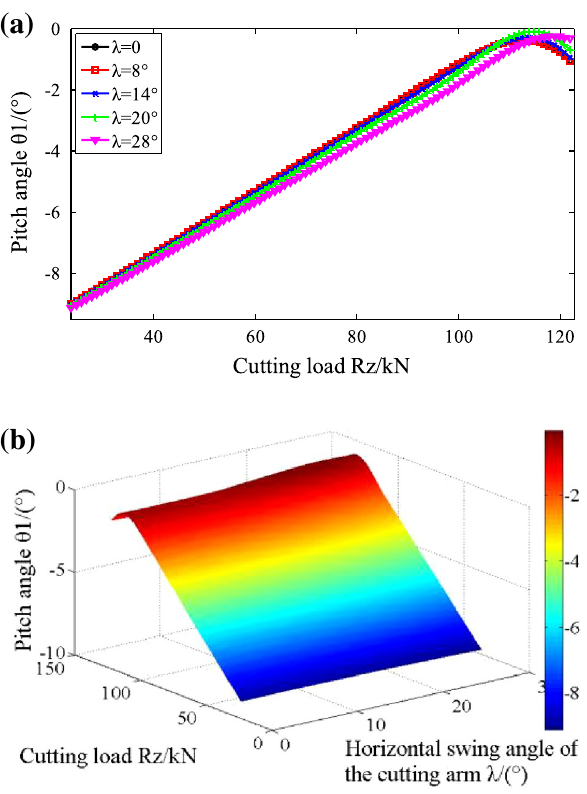
Fig. 11 Response regularities of the roll angle during the horizon- tal cutting process. ( a ) Relationship between the roll angle and the cutting load; ( b ) Relationship of the roll angle, cutting load and hor- izontal swing angle of the cutting